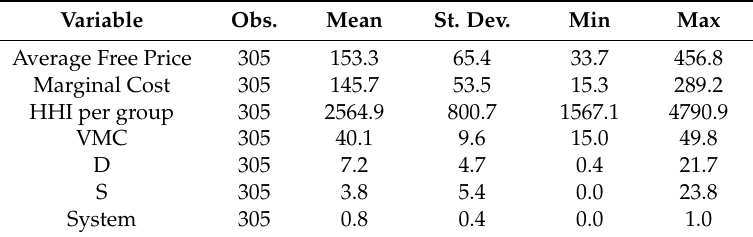
Table 2. Descriptive Statistics.